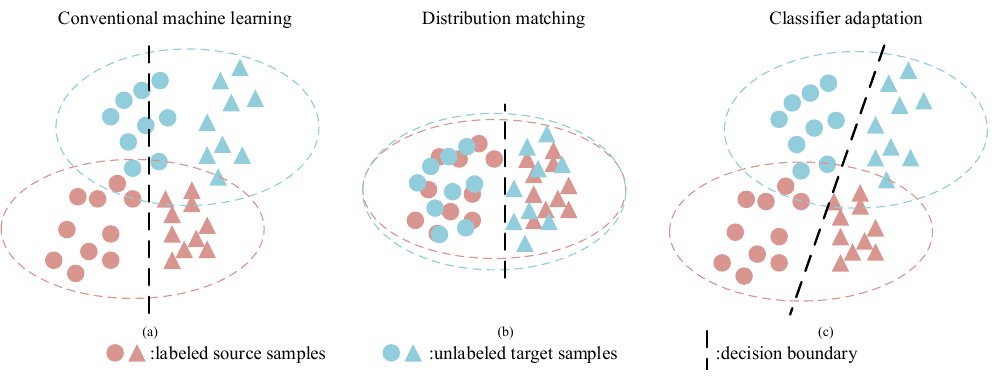
Figure 1. Different measures for cross-domain recognition